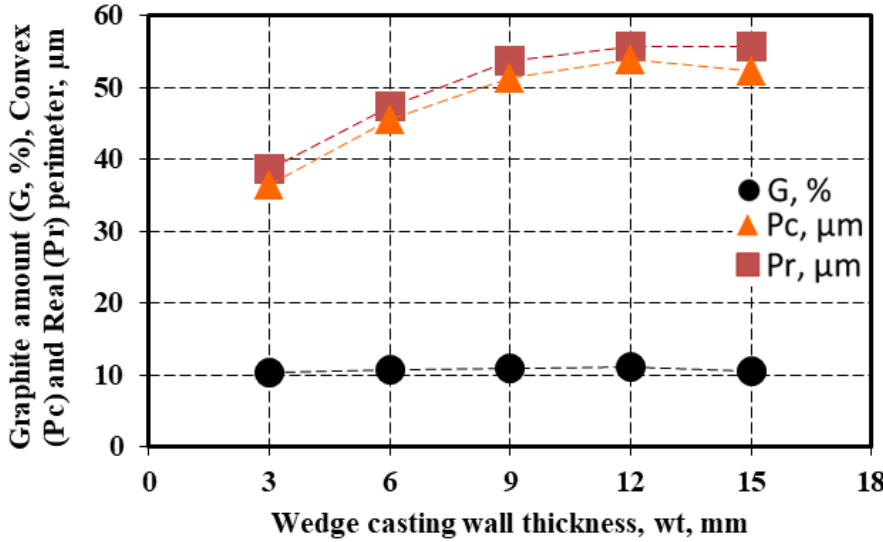
Figure 8. Influence of the wedge casting wall thickness on the average graphite amount (G), convex perimeter (P c ), and real perimeter (P r ) of graphite particles.